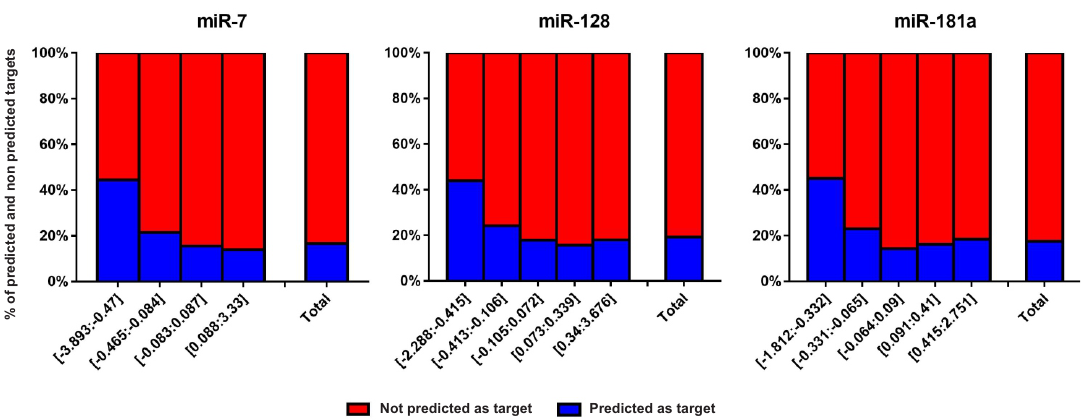
Figure 4. Proportion of genes predicted and do not predicted as targeted by miRNAs belonging to each cluster of miRNA-responsive genes for miR-7, miR-128, and miR-181a. Additional data of other miRNAs can be found in the Supplementary Figure